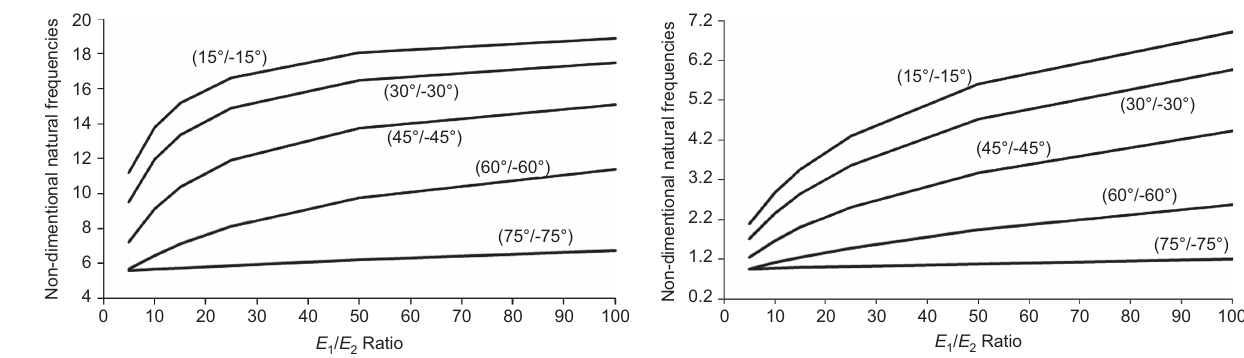
/ E ratio changing with L / h = 1 2